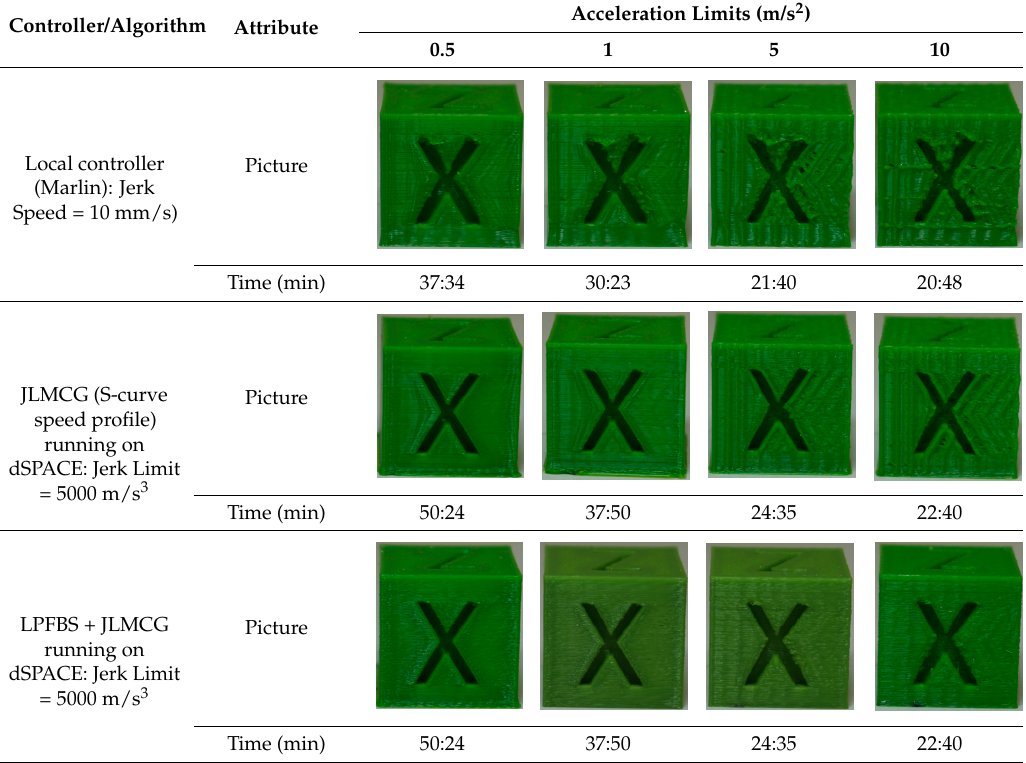
Table 2. Quality and printing time of X-face of Calibration Cube printed using the local controller (Marlin) as well as using a jerk-limited motion command generation (JLMCG) algorithm [30] (i.e., S-curve speed profile) and the limited-preview filtered B-spline (LPFBS) vibration compensation algorithm [31] both running on a high-end real-time control board (dSPACE DS1007). Note that the default acceleration limit and jerk speed of Taz 6 in Marlin are 0.5 m/s 2 and 10 mm/s, respectively.